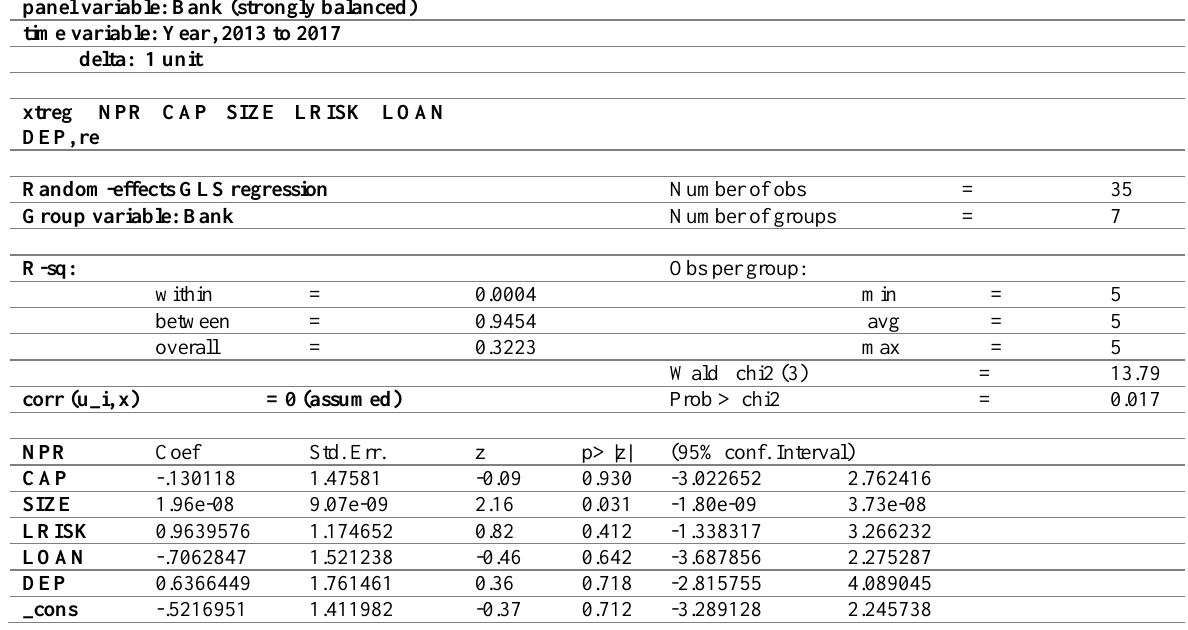
Table 6: Analysis of the Influence of Bank-Specific Factors on